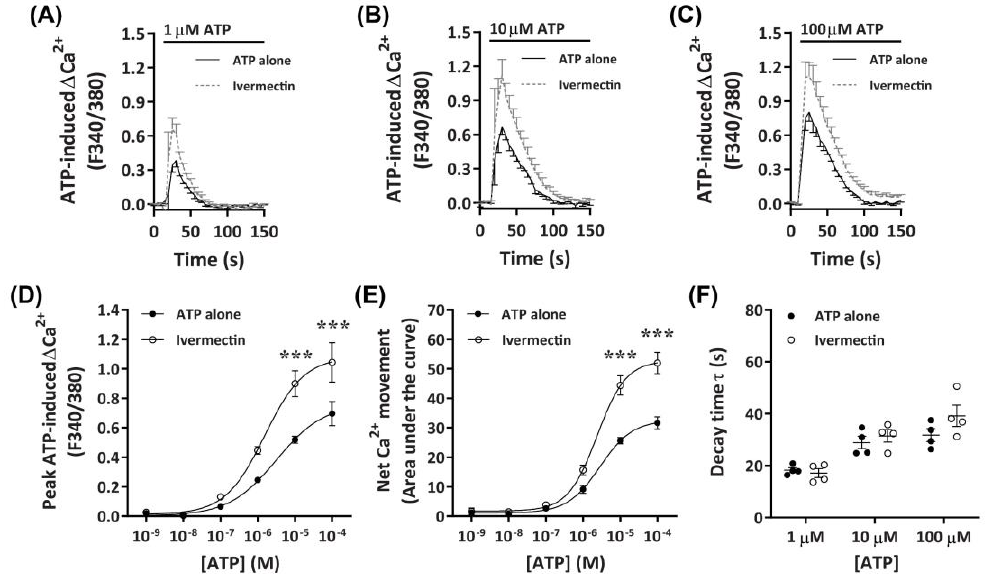
Figure 6. ATP-induced Ca 2+ responses in DH82 cells in the absence or presence of ivermectin. ( A – F ) DH82 cells in ECS were loaded with Fura-2 and preincubated in the absence (ATP alone) or presence of 3 µM ivermectin (both 0.1% DMSO) for 5 min. Cells were then exposed to increasing concentrations of ATP and Fura-2 fluorescence was recorded. ( A – C ) ATP-induced Ca 2+ traces (F340/380) were plotted and the ( D ) peak Ca 2+ response and ( E ) net Ca 2+ movement were fit to the Hill equation to produce concentration-response curves. ( F ) One phase decay time (τ) calculated from the peak of each Ca 2+ trace in ( A – C ). ( A – F ) Data shown are mean ± SEM from five independent experiments. ( D – F ) *** p < 0.001 compared to respective concentration of ATP alone analysed using a two-way ANOVA with Bonferroni post hoc test.